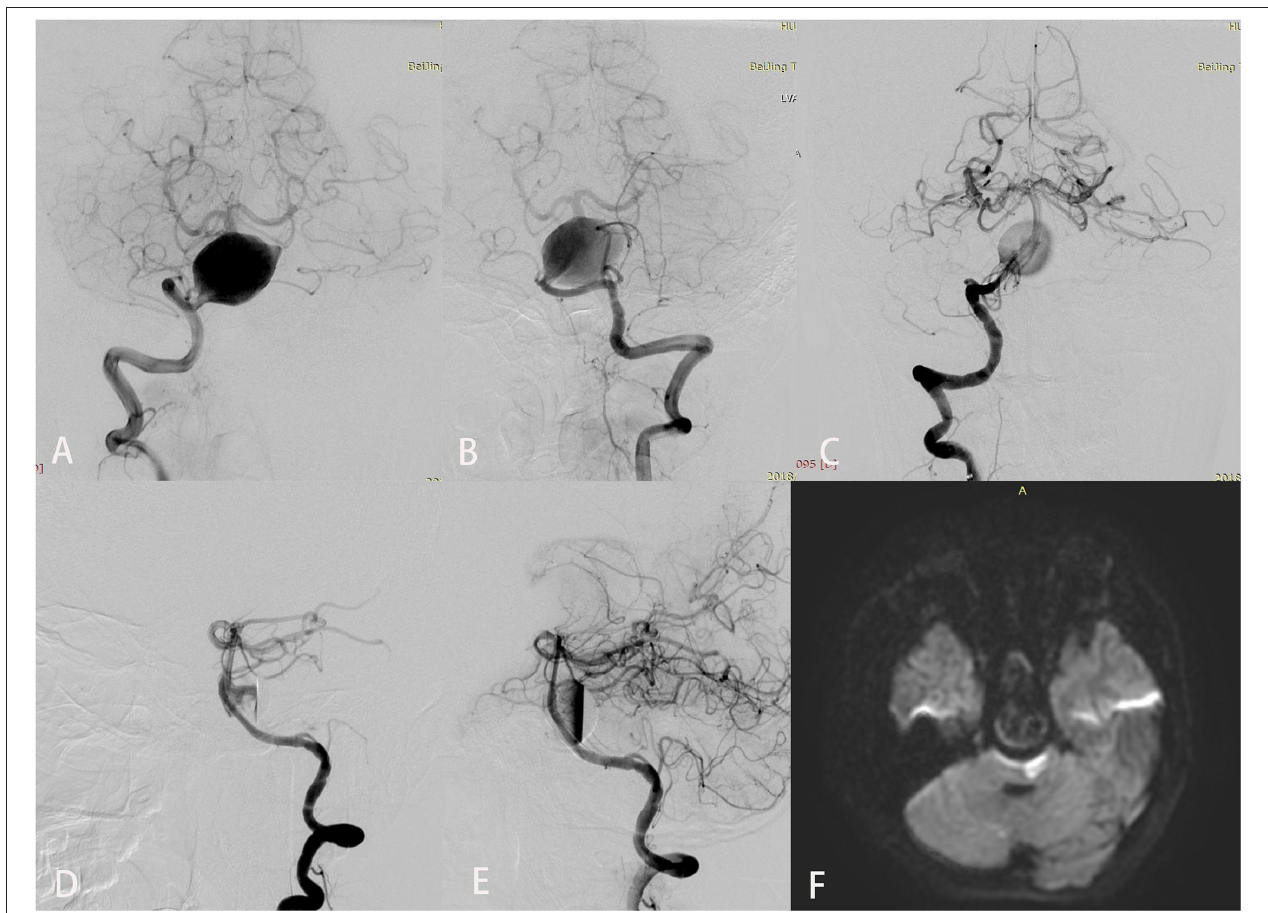
FIGURE 1 | Imaging studies for a 12-year-old boy (case 7) who presented with an 8-month history of chronic headaches and vertigo. Preoperative anteroposterior views of right (A) and left (B) vertebral angiography showed a giant fusiform basilar artery aneurysm. Anteroposterior (C) and lateral (D) views of right vertebral angiography immediately after treatment demonstrated excellent reconstruction of the basilar artery with 4 Pipeline embolization devices. An inflow jet is seen in the early arterial phase in (D) . (E) In the late arterial phase, contrast stasis is seen in the lumen of the aneurysm. Diffusion-weighted imaging (F) obtained to evaluate dysarthria and right hemiplegia that developed 12h after the procedure showed a large brainstem